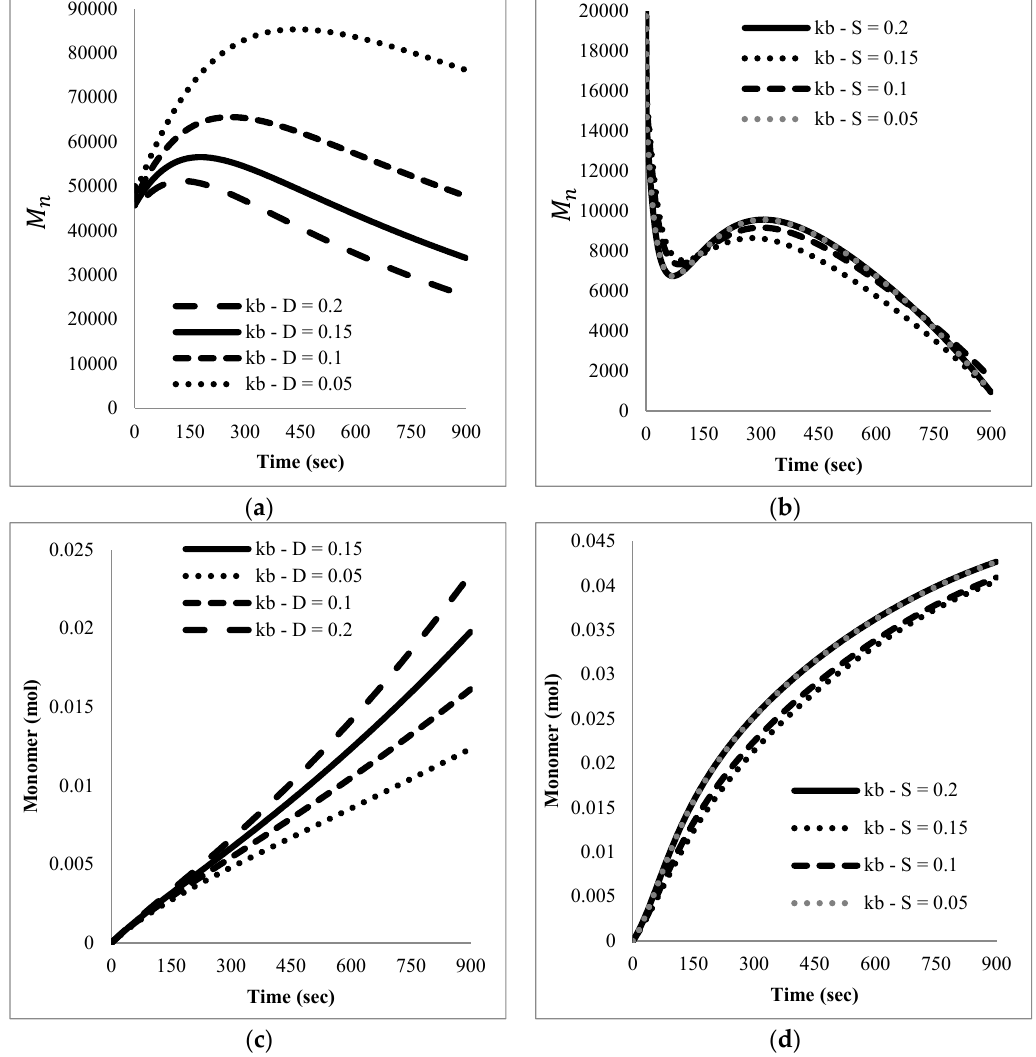
Figure 11. Effect of the variation of the mid-chain random scission coefficient, k b , value on the pyrolysis M n evolution of ( a ) dead polymer and ( b ) dormant polymer, and on the monomer generation of ( c ) dead polymer and ( d ) dormant polymer.